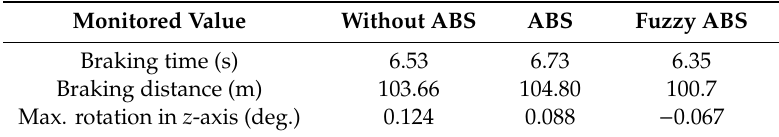
Figure 10. Test on dry road at speed 100 km/h—( a ) Speed curve; ( b ) Braking distance; ( c ) Vehicle rotation. Table 3. Test results on dry road at speed 100 km/h. Table 3. Test results on dry road at speed 100 km / h.